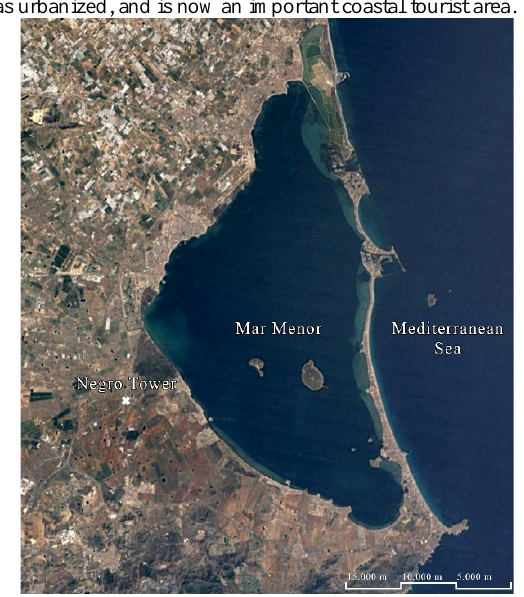
F igure 1. Location of the Negro Tower within the Mar